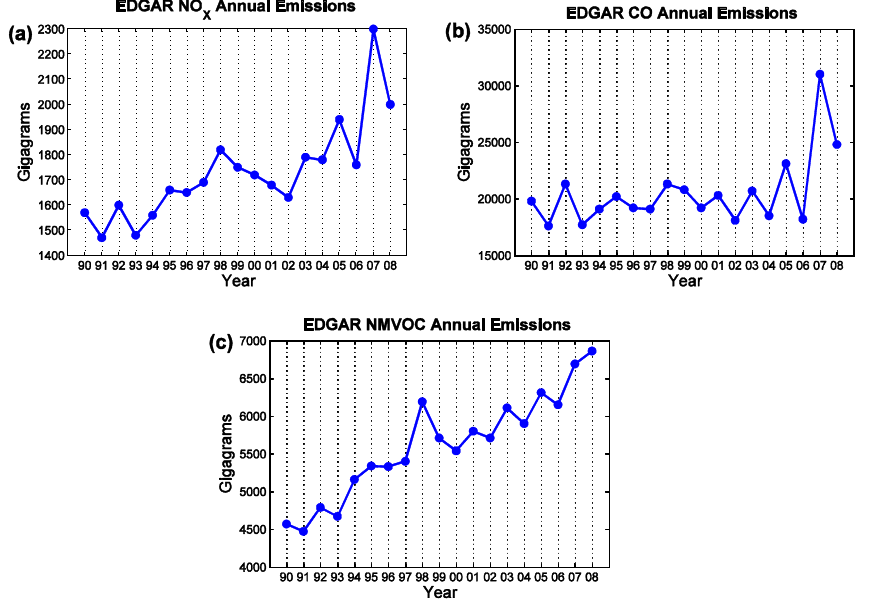
Figure 13. EDGAR annual emissions (total country EDGAR V4.2 emissions from http://edgar.jrc.ec.europa.eu/index.php), in Gg (giga- grams) of the principal tropospheric ozone precursors (a) nitrogen oxides (NO x ) , (b) carbon monoxide (CO) and (c) non-methane volatile organic compounds (NMVOC) over selected African countries that correspond to trajectory origins in Fig. 12.